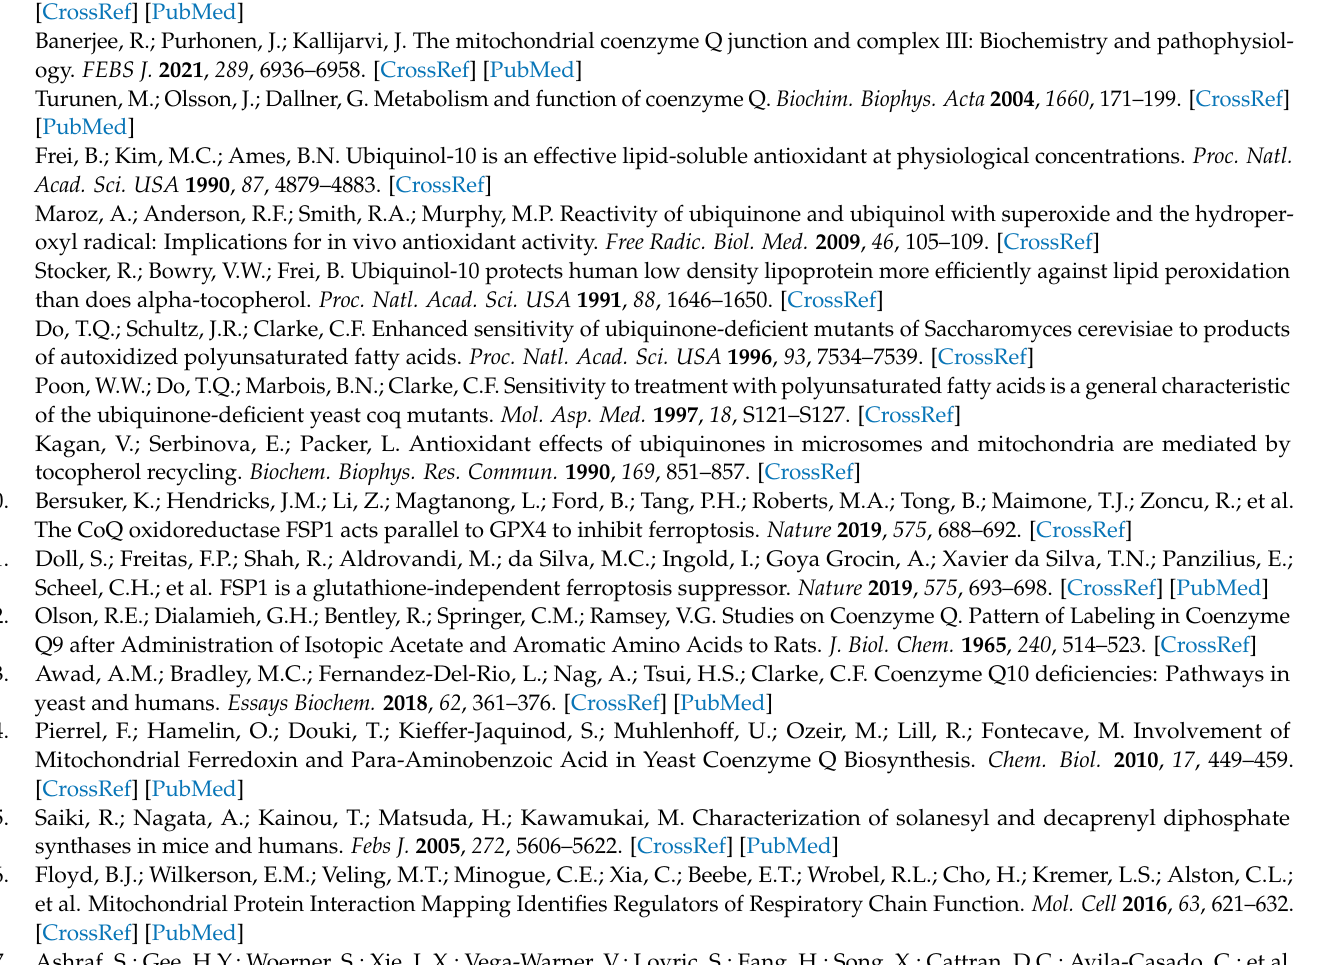
Figure A4. AlphaFold model of single chain of COQ9. Model color corresponds to the model confidence described in Figure 4. Figure was generated by the AlphaFold Protein Structure Database [39,54].